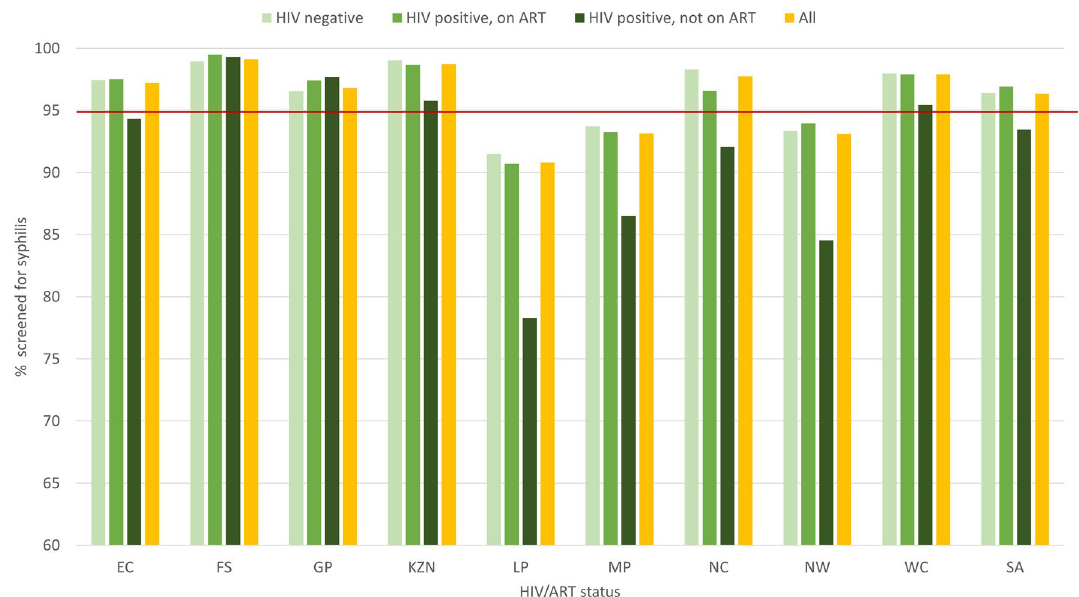
Figure 2. Syphilis screening coverage by province and HIV/ ART status. ART = antiretroviral therapy; Red line = global screening coverage target of 95%; EC = Eastern Cape; FS = Free State; GP = Gauteng; KZN = KwaZulu Natal; LP = Limpopo; MP = Mpumalanga; NC = Northern Cape; NW = North West; WC = Western Cape; SA = South